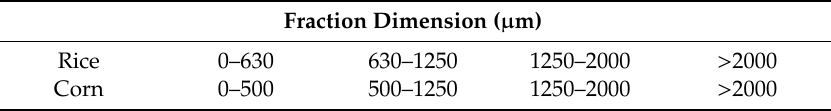
Table 3. Dimensions of rice and corn fractions used for